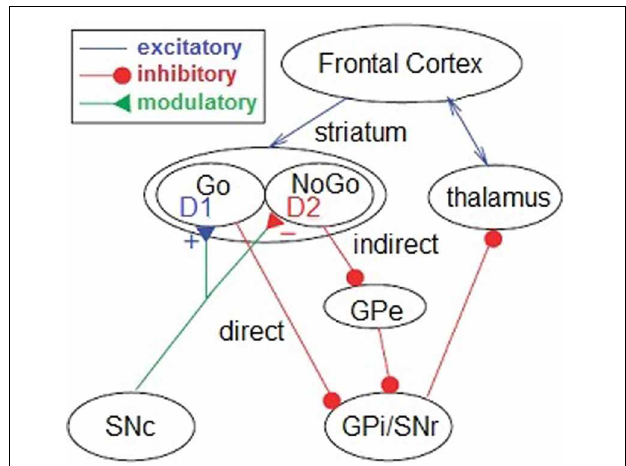
FIGURE 1 | Reinforcement learning model. In the reinforcement learning model (from Frank et al., 2004), phasic increases in dopamine promote action selection in the thalamus via the D1-receptor “Go” pathway, whereas phasic decreases promote action avoidance via the D2-receptor “NoGo” pathway. Both processes originate in the striatum and receive cortical and subcortical inputs. SNc, substantia nigra pars compacta;